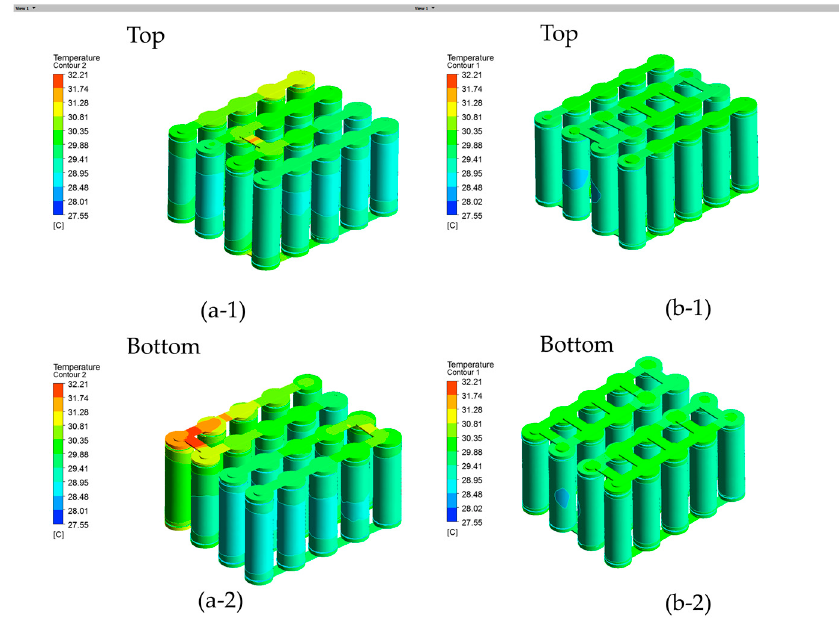
Figure 16. Battery module temperature contour viewed from top (upper) and bottom (lower) at a 2C discharge rate and 25 °C ambient temperature: ( a-1 ) and ( a-2 ) are model A and ( b-1 ) and ( b-2 ) are model B.